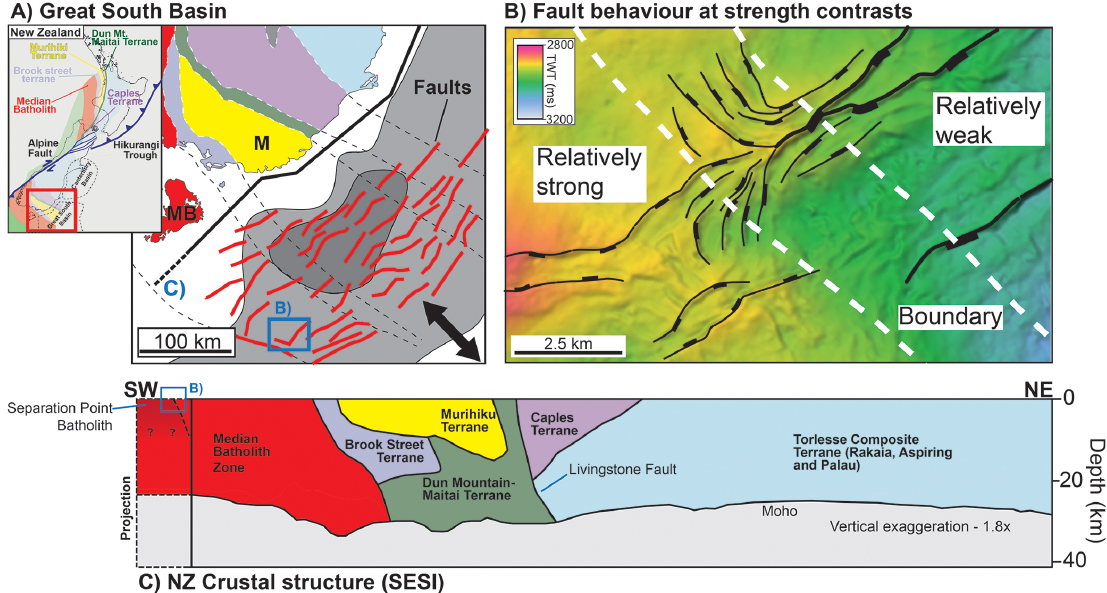
Figure 1. (a) Map showing the basement terranes present beneath the South Island of New Zealand and their offshore projections beneath the Great South Basin. Offshore terrane projections follow Ghisetti (2010) and Mortimer et al. (2002). MB stands for Median Batholith, and M stands for Murihiku Terrane. The main faults shown follow Sahoo et al. (2020). (b) Two-way-time (TWT) structure map showing how faults splay and rotate along internal strength contrasts following Phillips and McCaffrey (2019). (c) Generalised crustal structure offshore of the eastern coast of the South Island of New Zealand based on the South East South Island (SESI) seismic survey following Mortimer et al. (2002). The southern end of the line is projected to incorporate the Separation Point Batholith along the southern margin of the Median Batholith Zone, and the hypothesised location of panel (b) is also